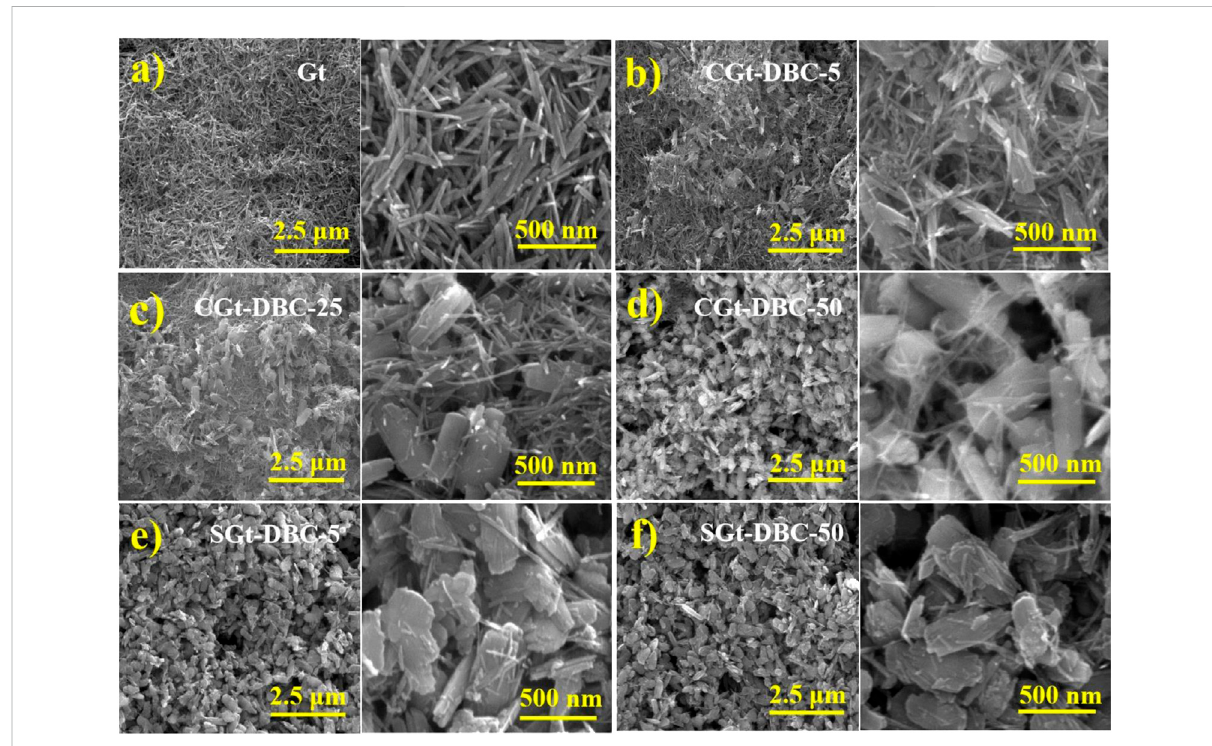
FIGURE 1 SEM images of samples: (A) Gt, (B) CGt-DBC-5, (C) CGt-DBC-25, (D) CGt-DBC-50, (E) SGt-DBC-5 and (F) SGt-DBC-50 (CGt-DBC, the coprecipitated Gt-DBC complexes; SGt-DBC, the adsorbed Gt-DBC complexes; Numbers indicate the additive concentration of DBC in the preparation of Gt-DBC samples).